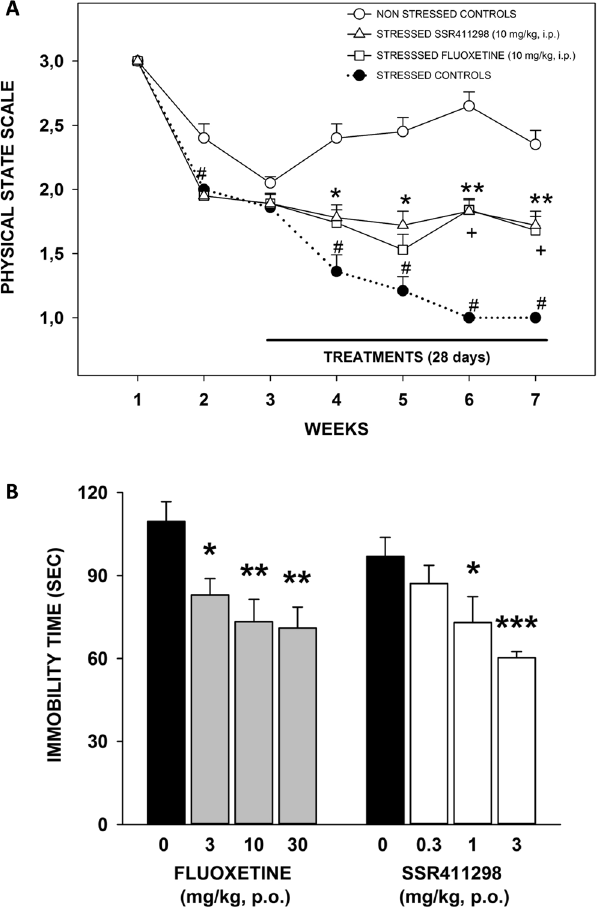
Figure 11. Effect of SSR411298 and fluoxetine in two models of depression: ( A ) the chronic mild stress procedure in mice. Data are expressed as mean physical state score ± SEM. # P < 0.01 (Wilcoxon test versus non stressed control group), * P < 0.05, ** P < 0.001 (Kruskal Wallis one sided upper multiple comparison tests with Bonferroni-Holm correction versus stressed control group). N = 14 to 20 mice per group; ( B ) the forced- swimming test in rats. SSR411298 was administered p.o. twice a day during 2 days, 60 minutes before pretest, immediately after, and 60 minutes before the second session of testing. Fluoxetine was administered p.o. twice (immediately after the first session, and 60 minutes before session 2). Data represent mean + SEM. * P < 0.05, ** P < 0.01 and *** P < 0.001. N = 6–7 rats per